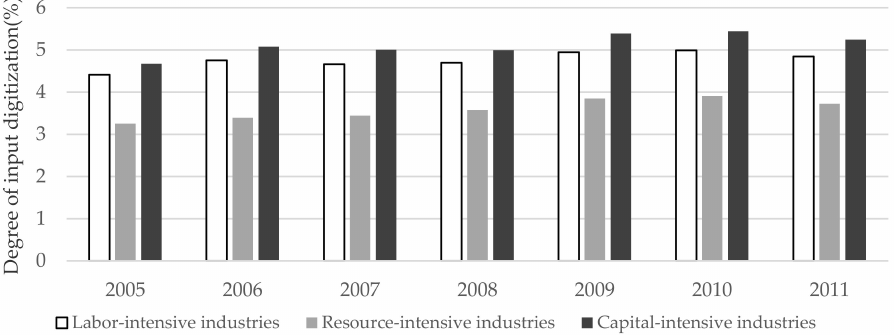
Figure 2. The trend of different types of manufacturing industries’ input digitization in the world.